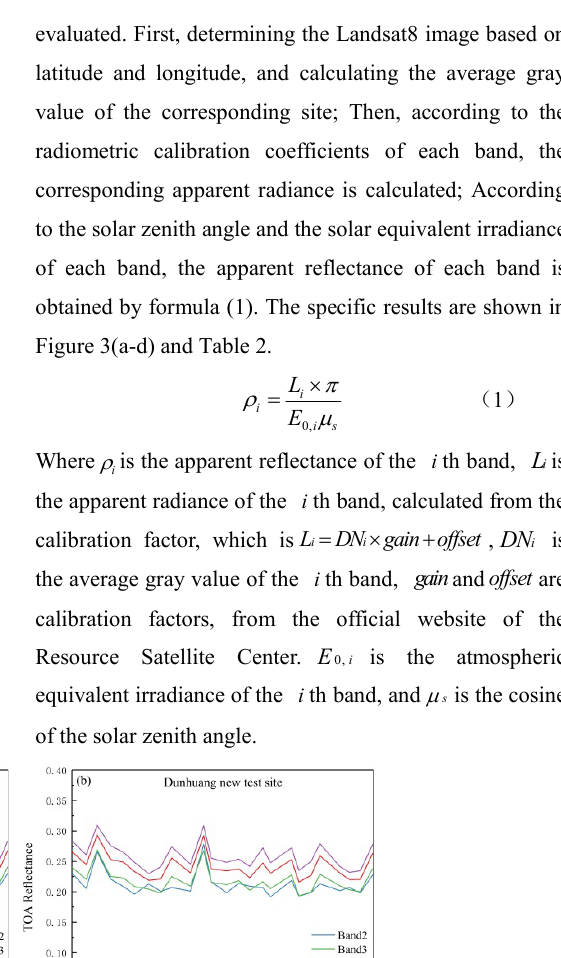
Figure 2. Location of the solar power station